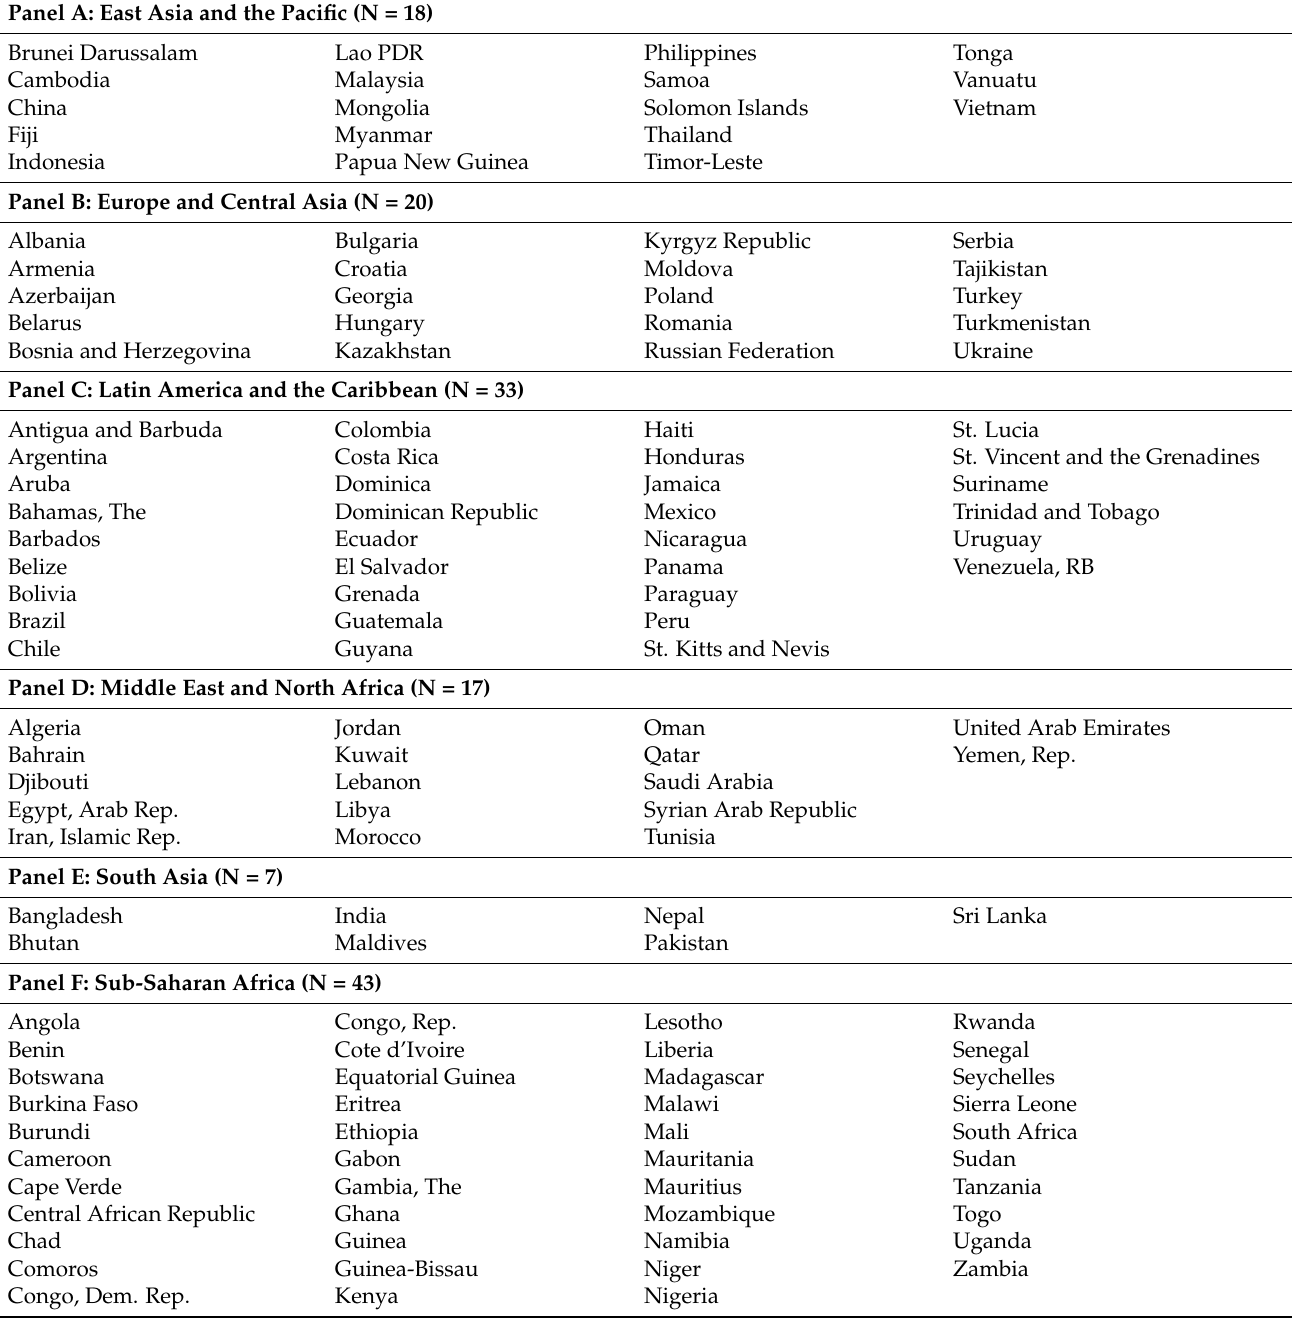
Table A4. List of countries by geographic